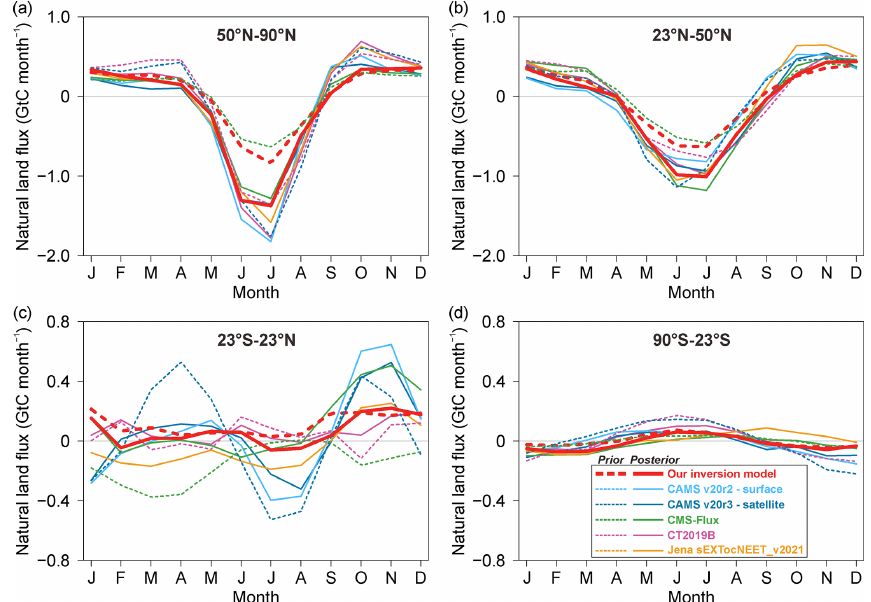
Figure 6. Seasonal cycle amplitudes of natural land fluxes over different latitudinal bands from 2015 to 2018. The global natural land fluxes (i.e., terrestrial biospheric + fire fluxes) averaged between 2015 and 2018 were split into four zonal bands: (a) northern high latitudes (50–90 ◦ N), (b) northern mid-latitudes (23–50 ◦ N), (c) tropics (23 ◦ S–23 ◦ N), and (d) southern extratropics (90–23 ◦ S). Each atmospheric inversion result was represented by solid curves (posterior flux) and dashed circles (prior flux (if any)). The colors of the atmospheric inversion models are the same as those shown in Fig. 3, and the references for each inversion model are listed in the caption of Fig.